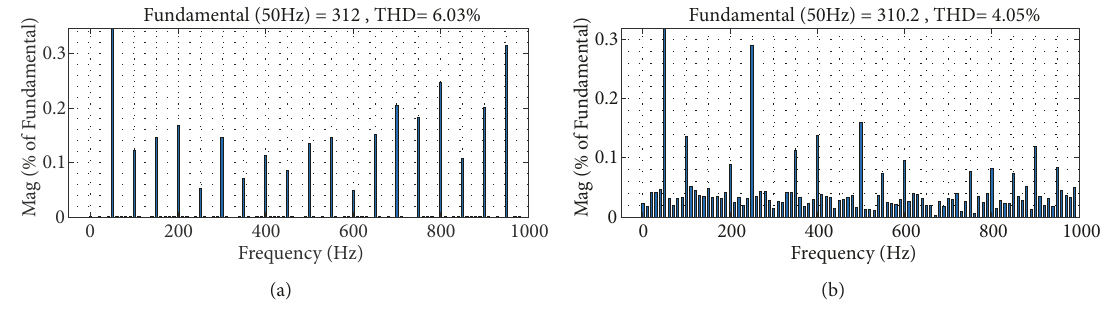
Figure 9: Total harmonic distortion of capacitor filter voltage at 50 𝜇 s sampling time for (a) the conventional MPVC and (b) the proposed